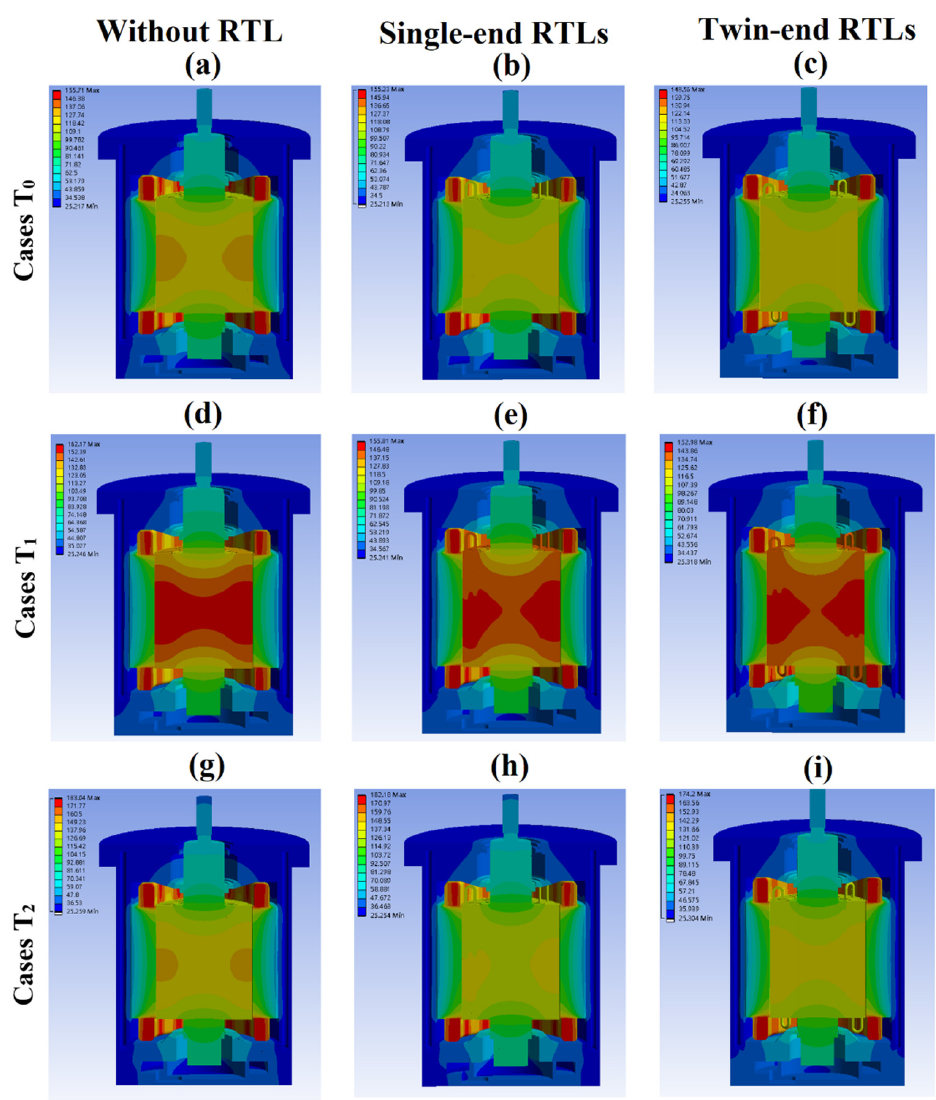
Figure 15. Temperature maps of PMSEMs with and without RTLs at T 0 –T 2 operating conditions. Cross examining the temperature maps obtained at T 0 and T 1 cases, the increase in elevates the overall temperature levels in the PMSEM without RTL. As the values of h ext,con